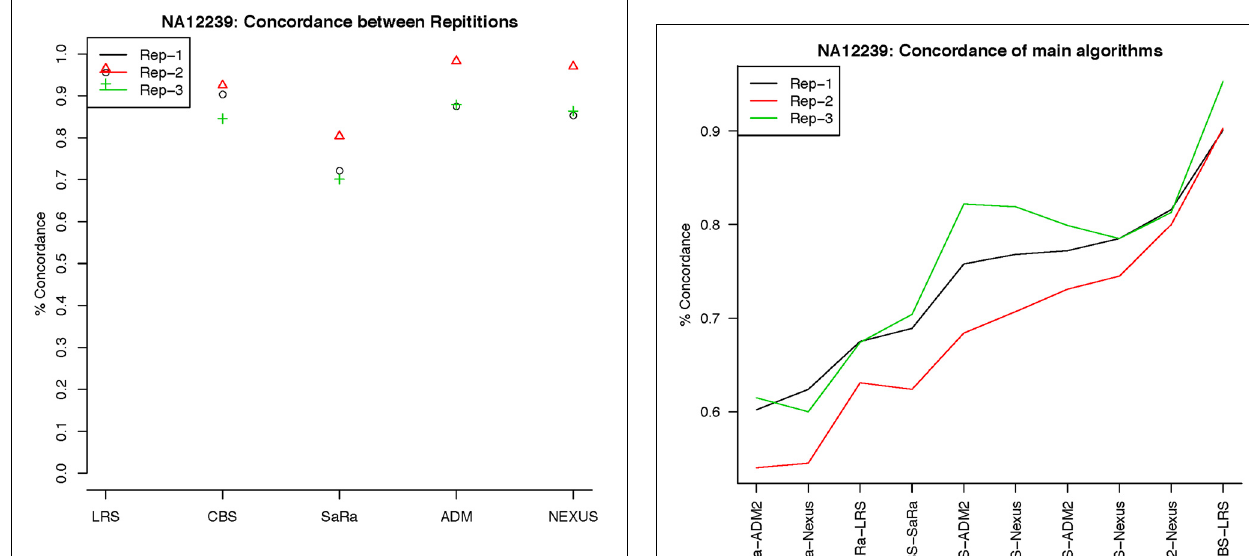
FIGURE 8 | This is % Concordance between repetitions for the same method for NA12239. Each sample was measured in triplicate so the probes declared CNV from one method on a repetition are compared to the probes declared as a CNV from the same method on a different repetition.